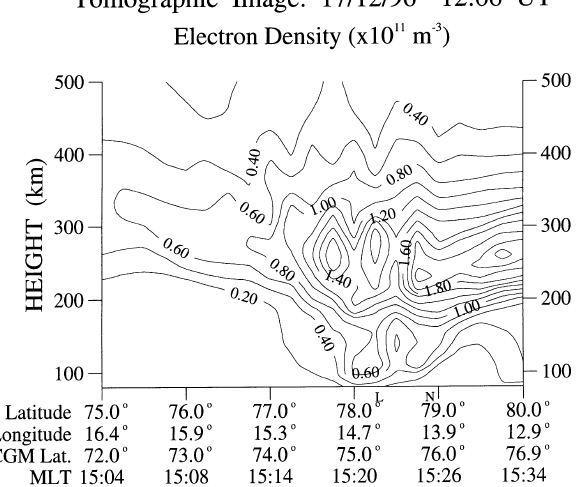
Fig. 7. Tomographic image of electron density for a satellite pass at 12:06 UT on 17 December 1996. The latitudes of Longyearbyen and Ny A˚ lesund are denoted by the letters L and